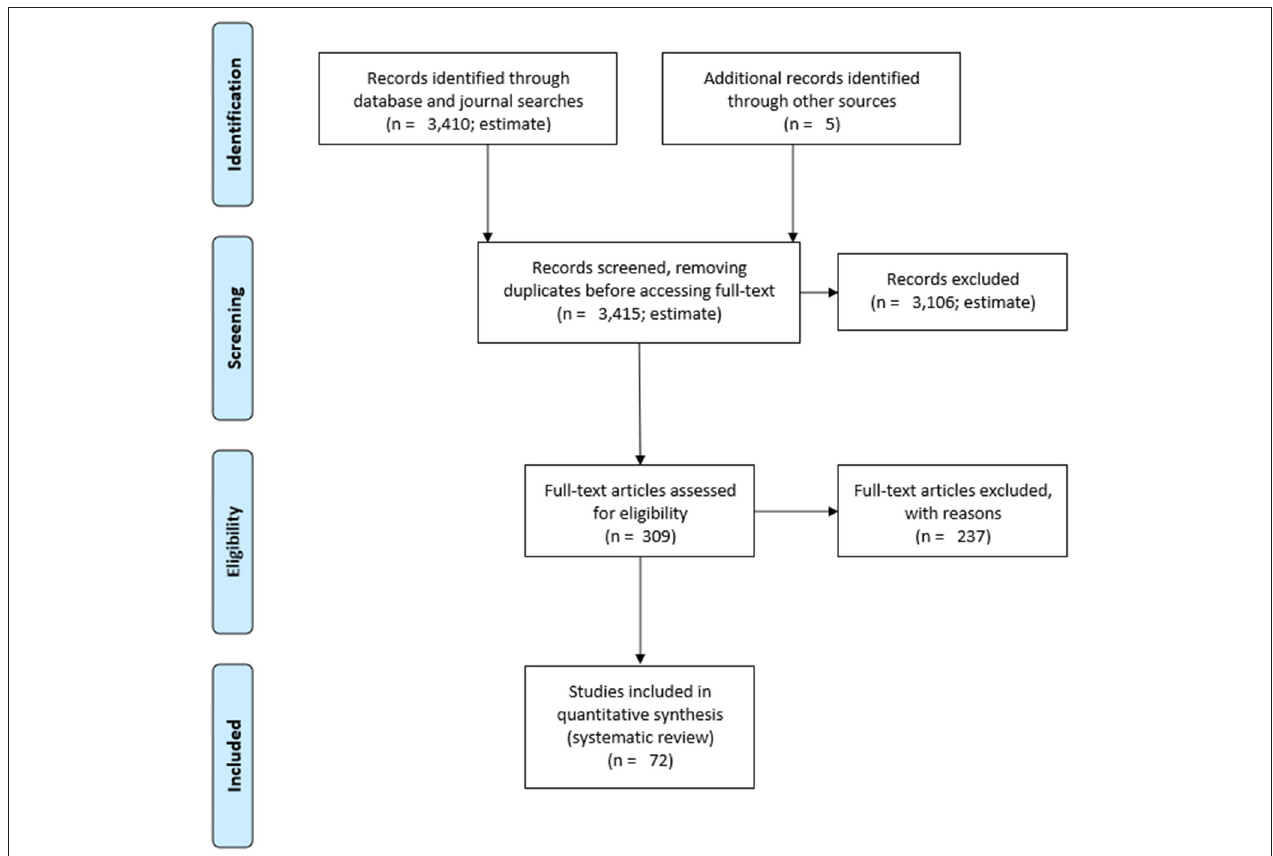
FIGURE 1 | PRISMA 2009 Flow diagram. Moher et al.